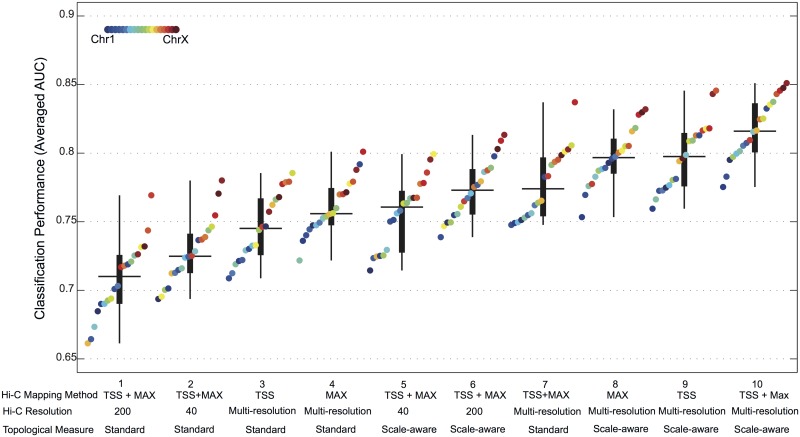
Classification performance for the co-expression prediction based on intra-chromosomal chromatin interaction networks.Each box encompasses the classifier performance in terms of AUC for all mouse chromosomes. Boxes are sorted based on their medians. The method that was used for computing the input feature set is given under each box. TSS or MAX refers to the mapping method for assigning Hi-C interaction between gene-pairs when the CIN is built. TSS + MAX refers to concatenated feature set of topological measures of CINs built using both TSS- and MAX-mapping methods. Multi-resolution refers to concatenated feature set of topological measures obtained from CINs at Hi-C resolutions of 40, 80, 120, 160, and 200kb. In each box, the horizontal line represents the median. The thick vertical line represents the interval of q
1 = 25th and q
3 = 75th percentiles. The thin vertical line represents the interval of q
3 + 1.5(q
3 − q
1) and q
1 − 1.5(q
3 − q
1). All the values shown in the figure are also available in S1 Table